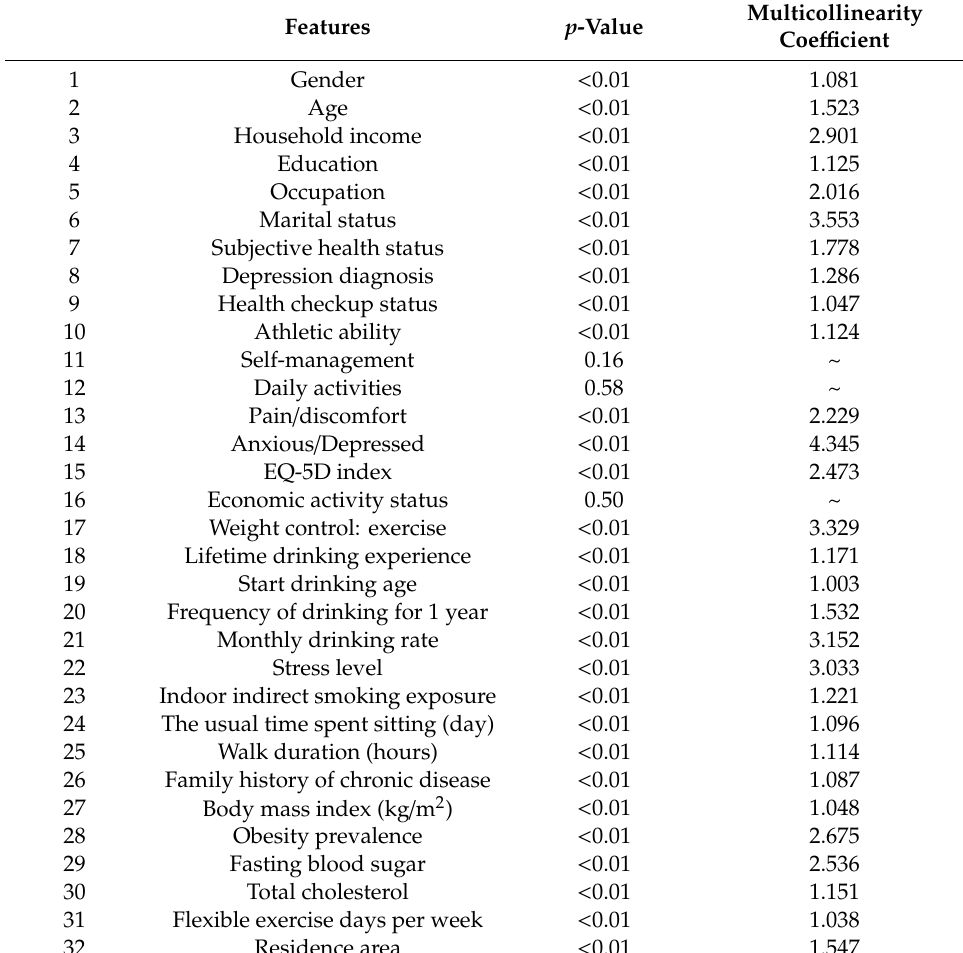
Table A2. Bivariate and Multicollinearity analysis for KNHANES dataset.